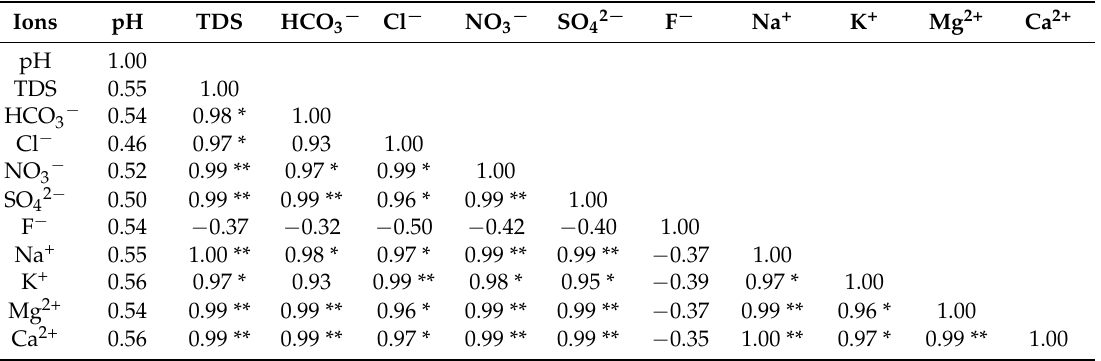
Table 2. The correlation of groundwater hydrochemical